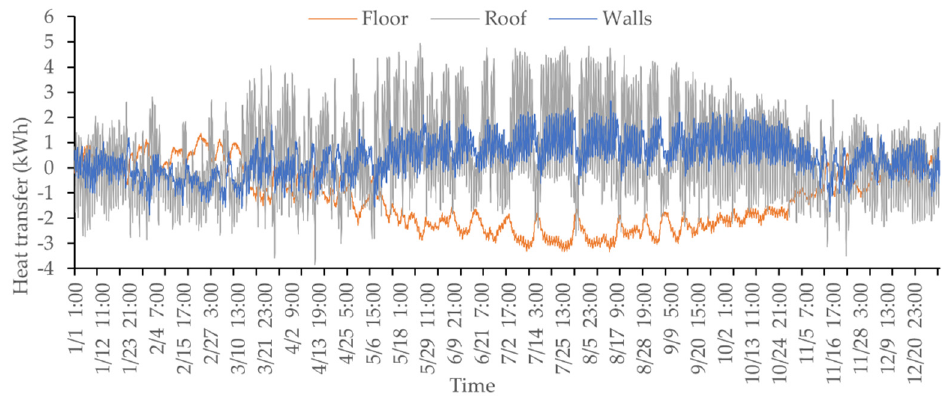
Figure 7. Hourly heat transfer of house envelope.